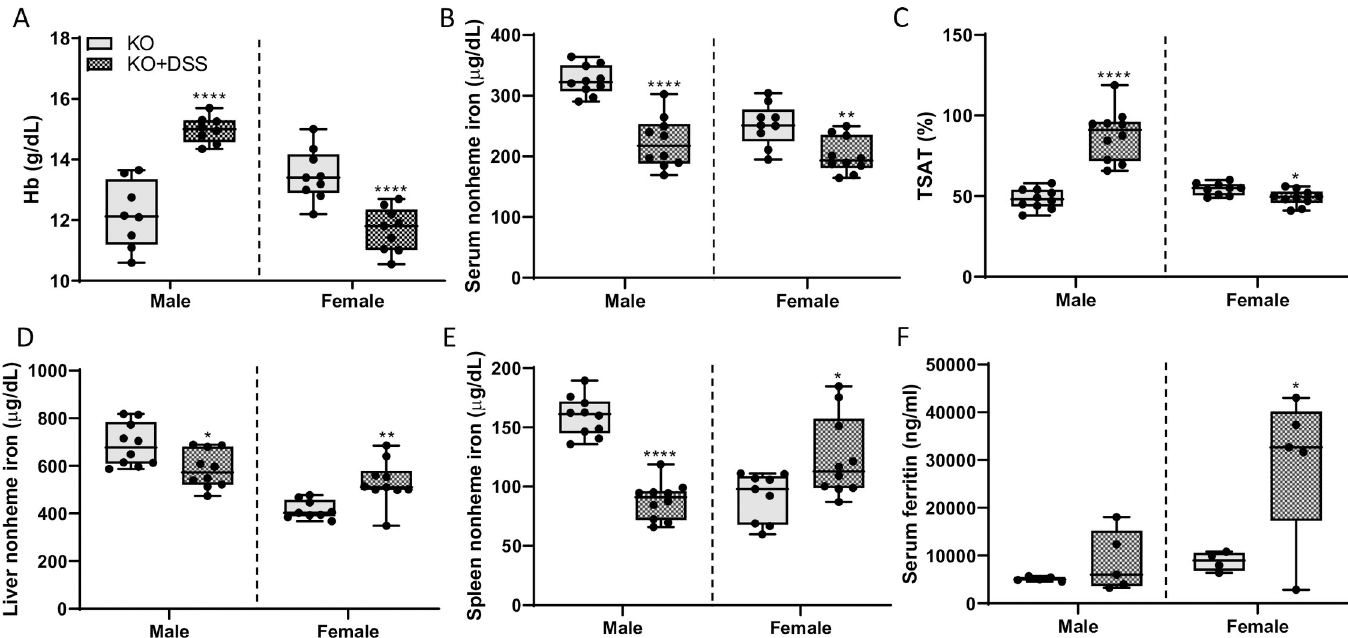
Fig 19. Intestinal inflammation differentially influences iron homeostasis in male and female Hamp -/- rats. Hb levels were assessed in 10-week-old control and DSS- treated hepcidin KO rats ( A ). Serum nonheme iron ( B ), TSAT ( C ), liver ( D ) and spleen ( E ) nonheme iron concentrations, and serum ferritin levels ( F ) were also determined using standard methodologies. Data are presented as box plots for n = 5–11 rats/group and were analyzed separately by sex using a t test ( � p = 0.0349; �� p < 0.0034; ��� p < 0.0006; ���� p < 0.0001).